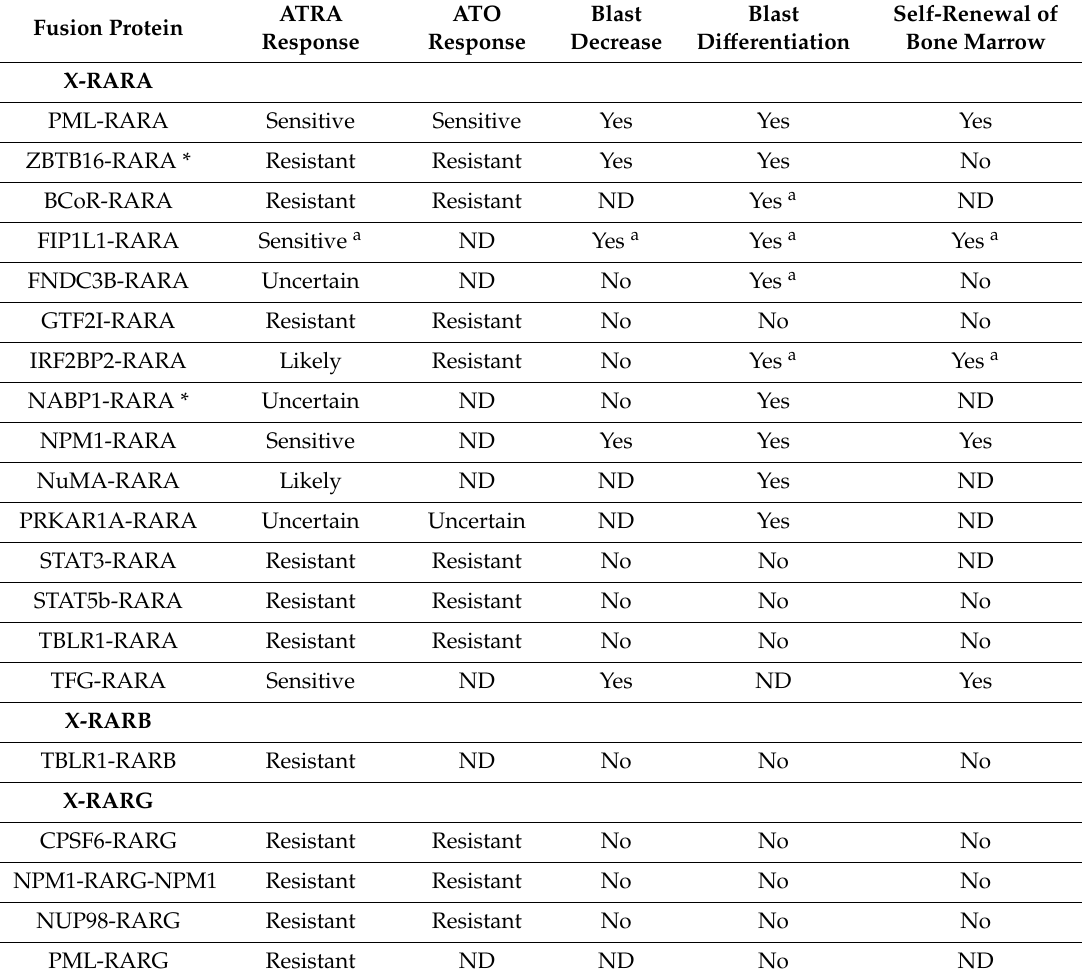
Table 2. ATRA / ATO therapy response for X-RARs